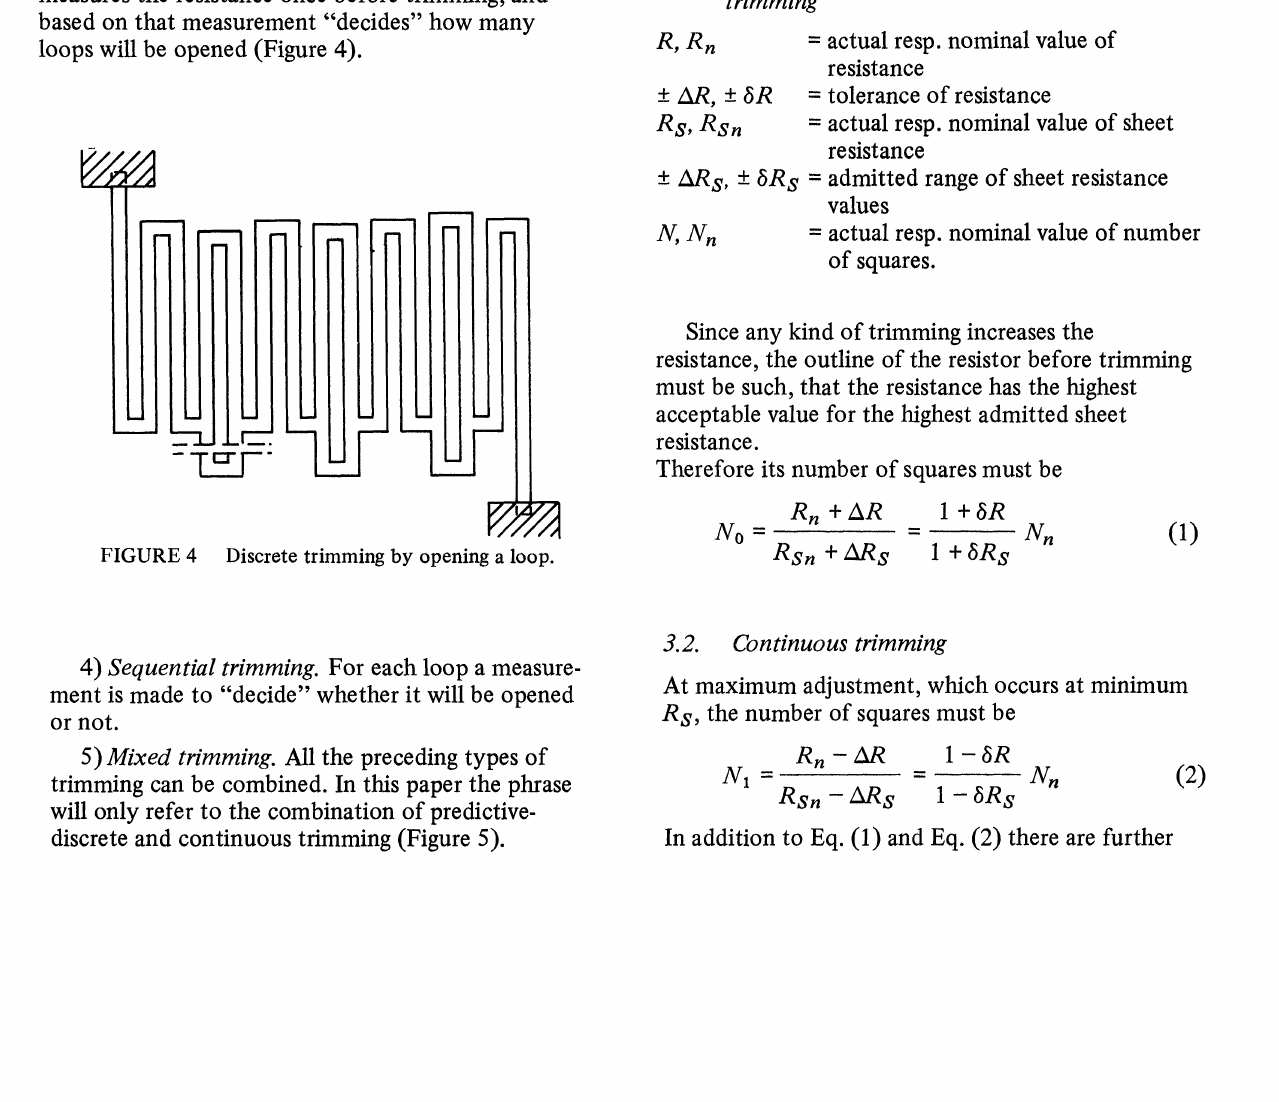
FIGURE 3 Continuous trimming.